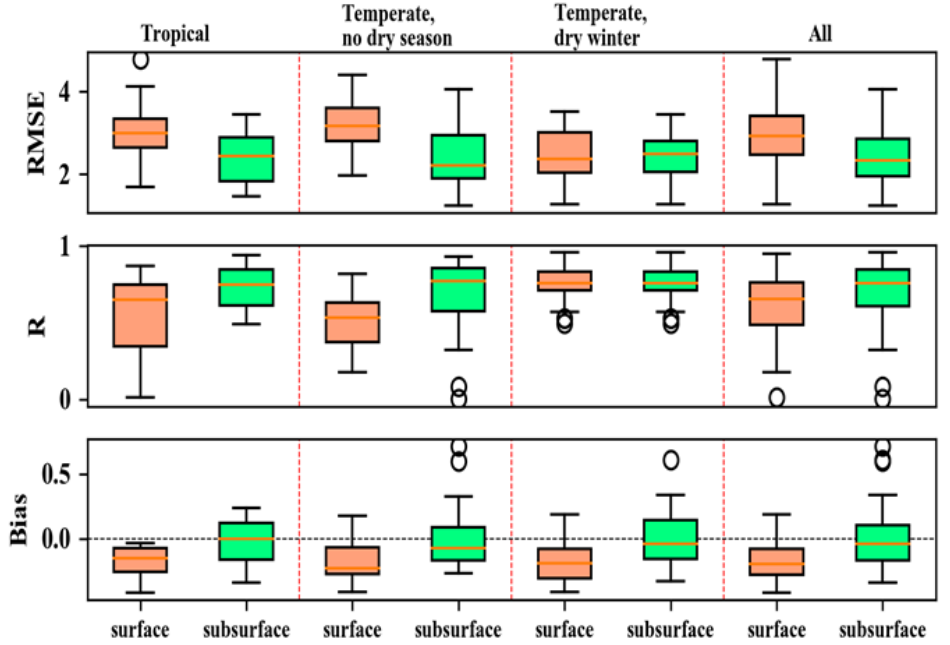
Figure 4. RMSE, R, and bias of the surface and subsurface weekly Soil Water Deficit Index (SWDI) between the ERA5-Land and in situ data in the three climate zones and the whole study area.